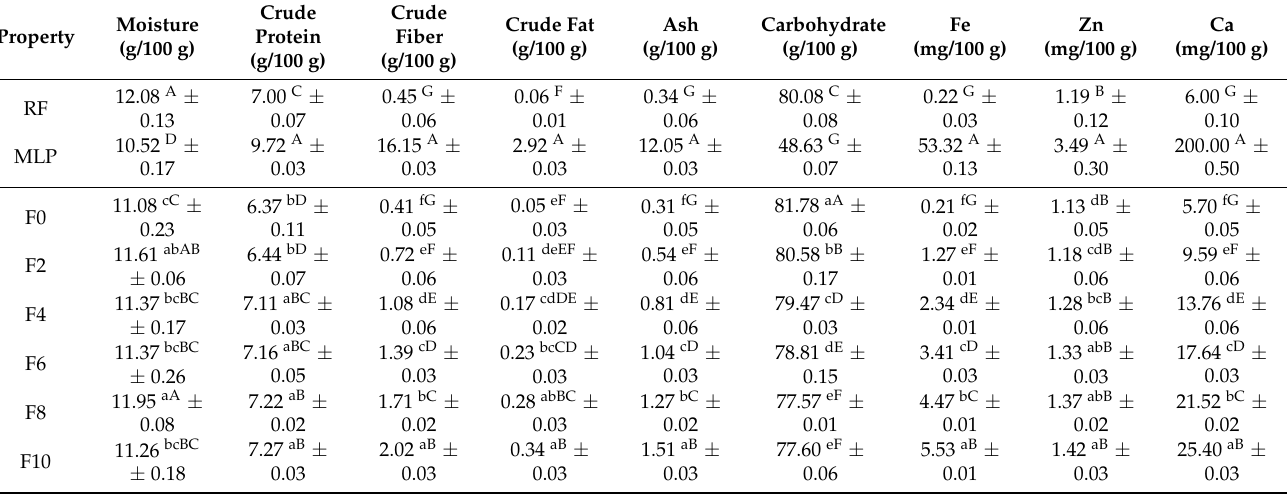
Table 1. Nutritional composition of RF, MLP, F0, and FRNs with different levels of MLP addition.